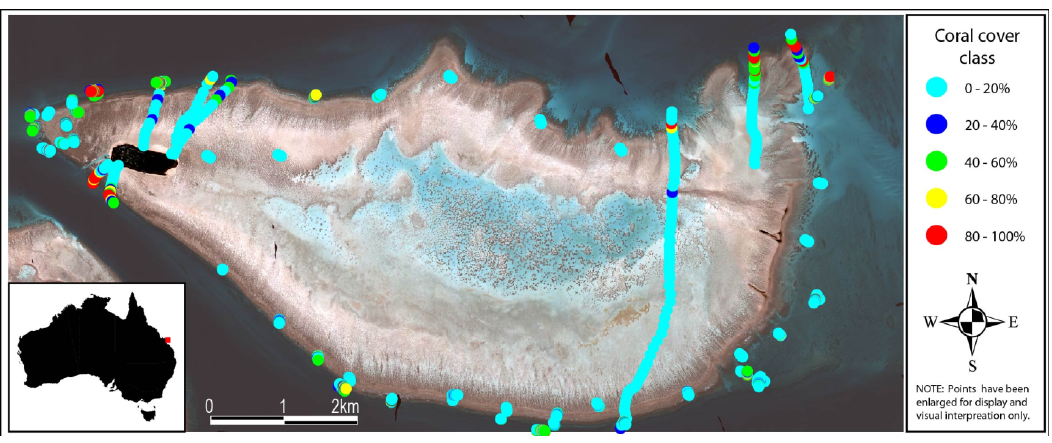
Figure 4. Field determined coral cover overlaid on CASI-2 image data. Each survey